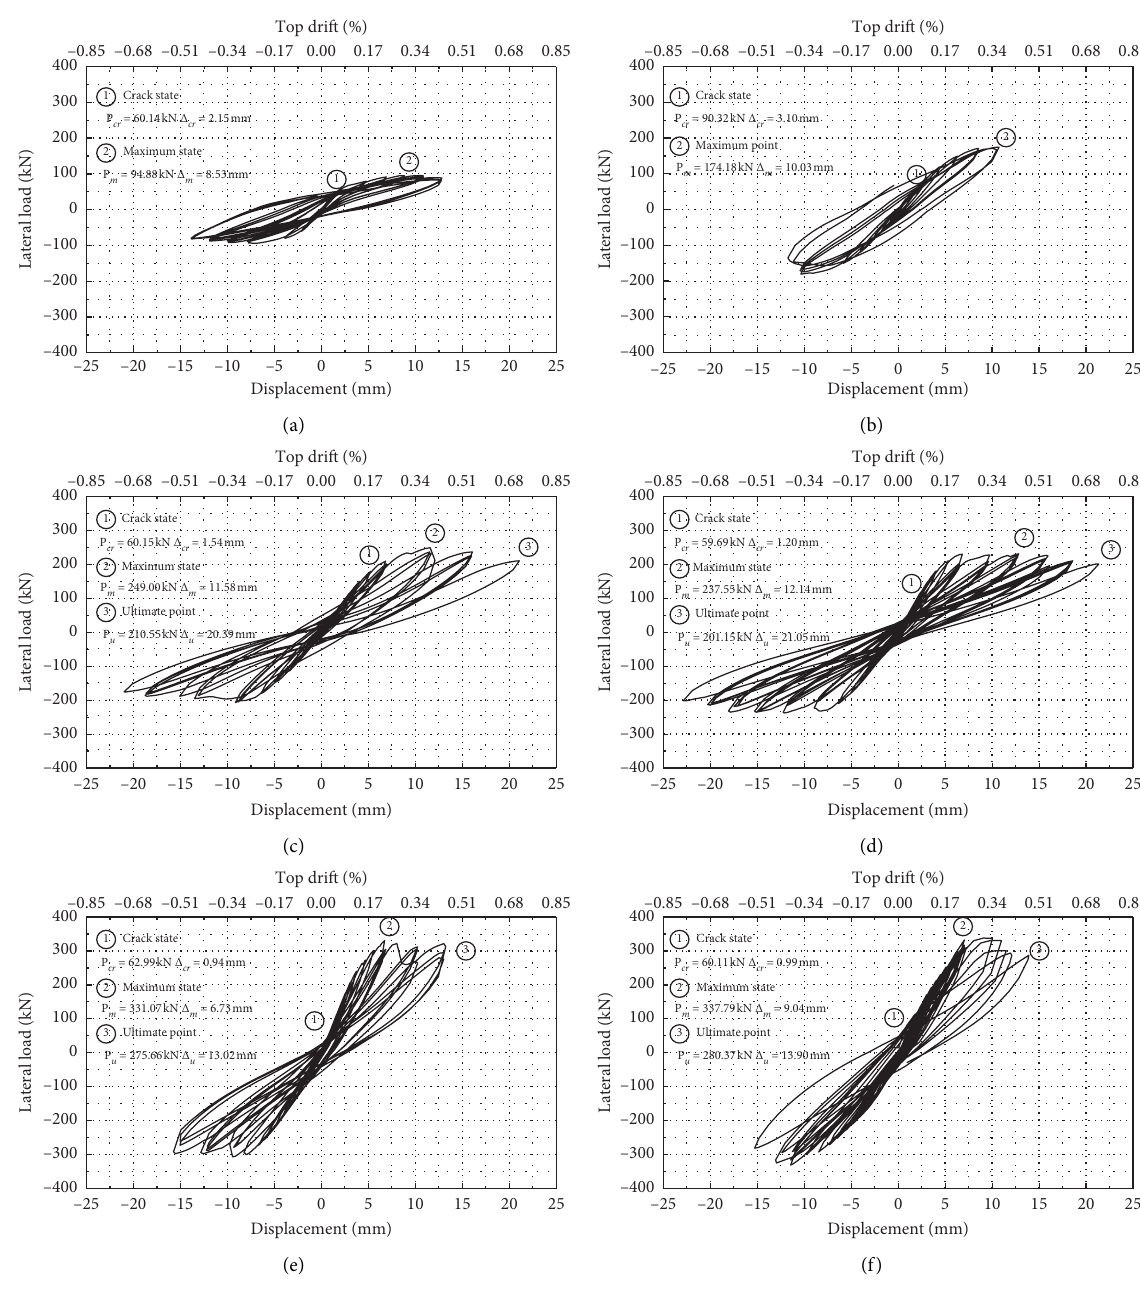
Figure 8: Hysteretic curves of specimens: (a) W1; (b) W2; (c) W3; (d) W4; (e) W5; (f) W6. Table 6: Characteristic load and